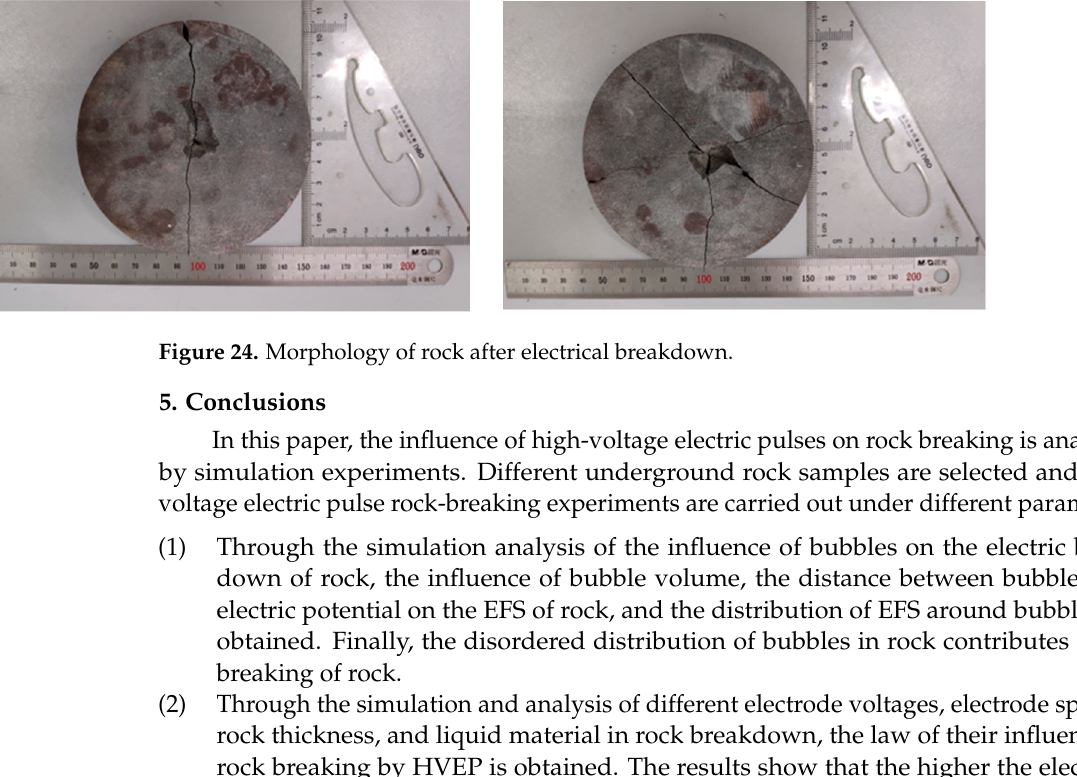
Figure 23. Voltage waveform of rock electrical breakdown experiment. ( a ) Non breakdown voltage; ( b ) breakdown voltage.